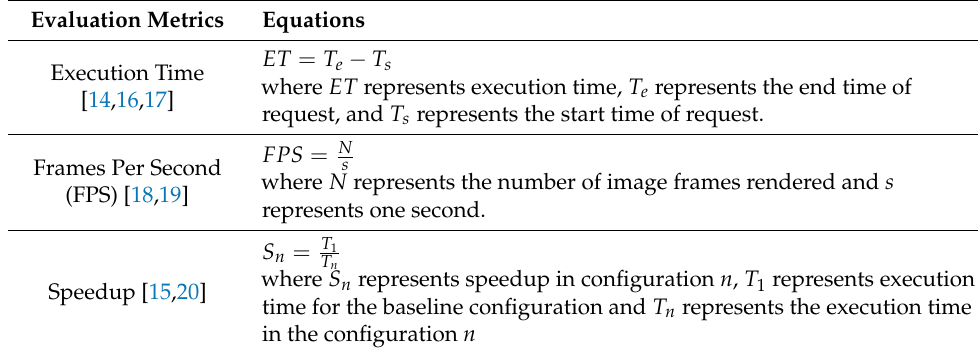
Table 2. Evaluation metrics used in the experiments and their respective